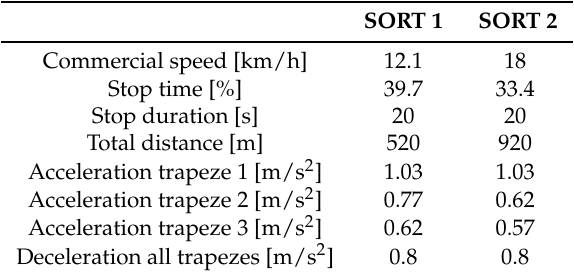
Table 4. Specifications of the two base cycles SORT 1 and 2 that are representative of heavy and easy urban driving with average speeds of 12.1 km/h and 18 km/h